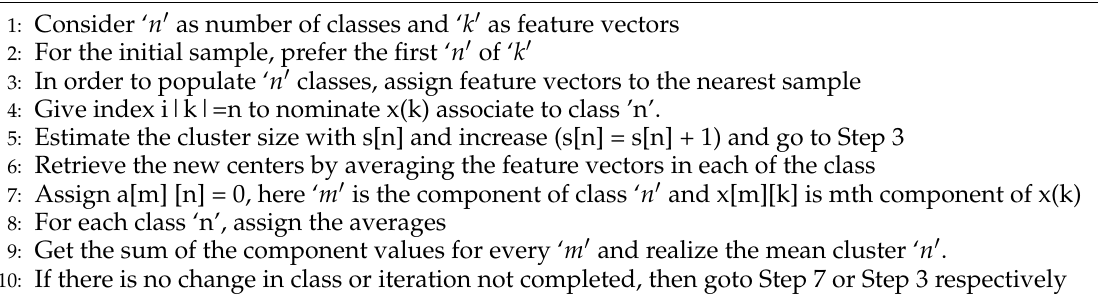
Algorithm 1 Procedure to cluster the data using minimum distance algorithm for training the data set.